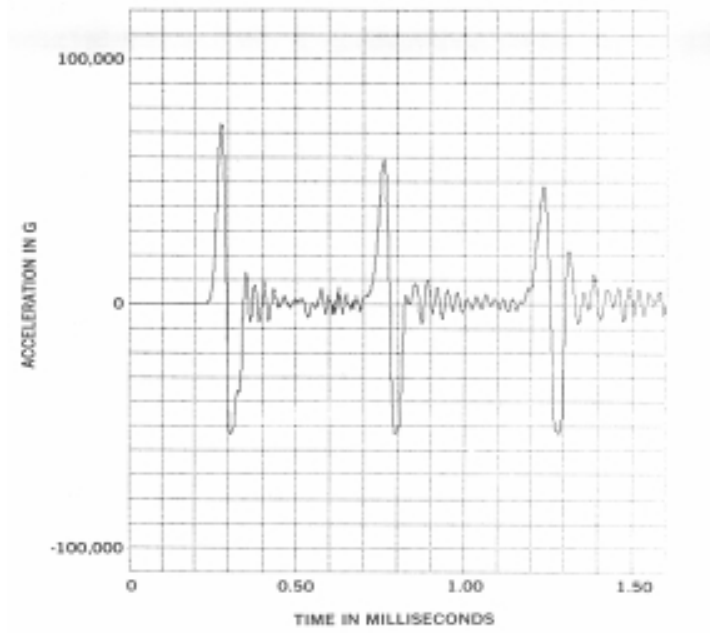
Fig. 11. PCB 305 response on a Hopkinson bar ( > 70,000